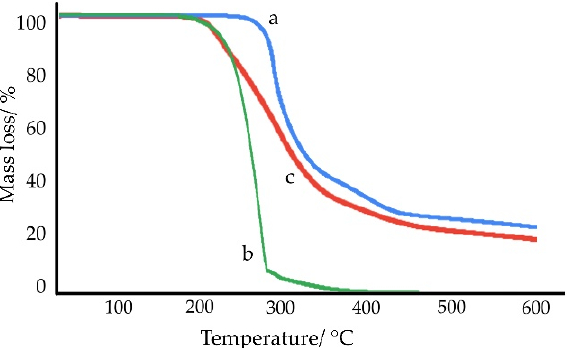
Figure 10. TGA curves for ( a ) chlordiazepoxide, ( b ) saccharin, and ( c ) chlordiazepoxide mixture with saccharin. Measurements were taken at a heating rate of 10 °C/min in nitrogen.